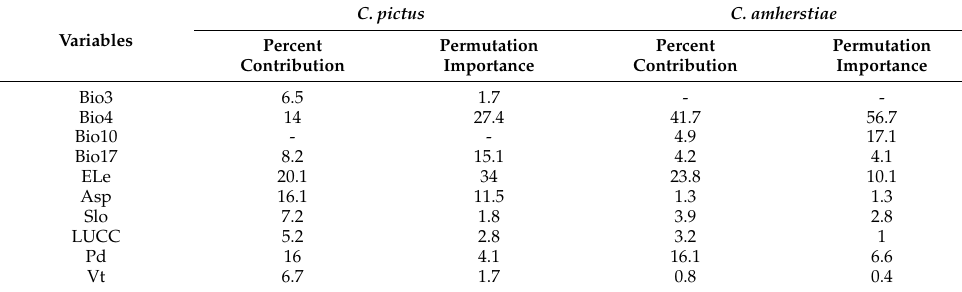
Table 2. Contribution analysis of predictor